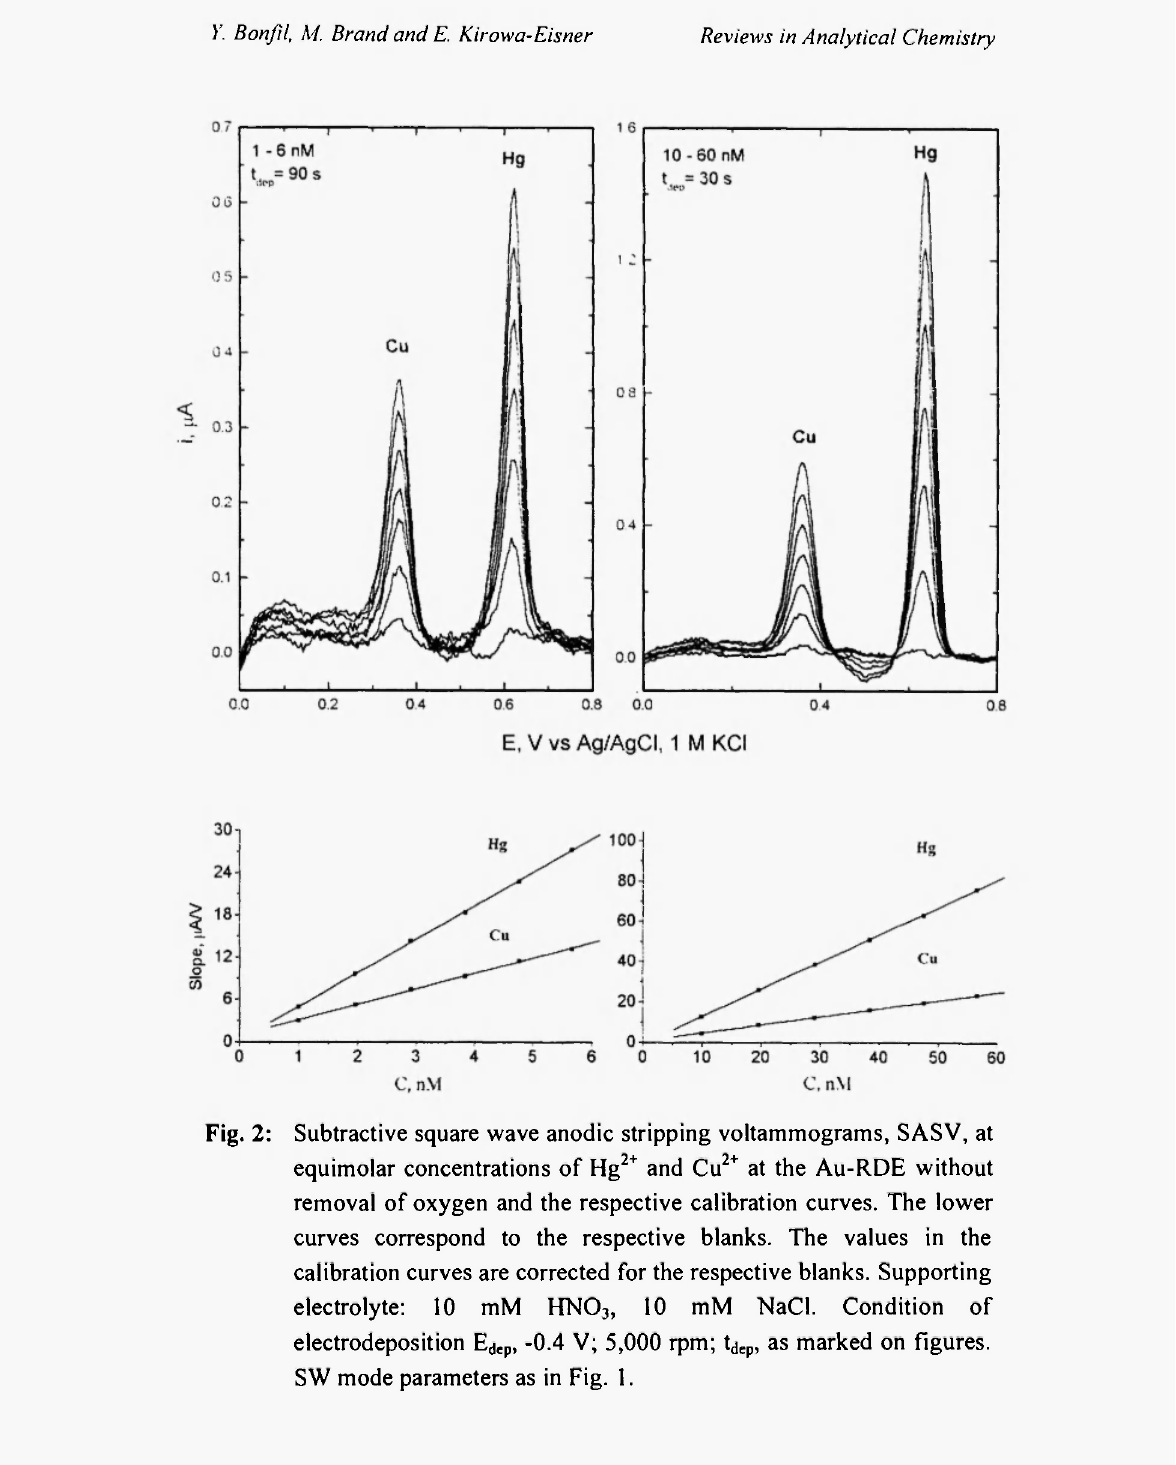
Fig. 2: Subtractive square wave anodic stripping voltammograms, SASV, at equimolar concentrations of Hg 2+ and Cu 2+ at the Au-RDE without removal of oxygen and the respective calibration curves. The lower curves correspond to the respective blanks. The values in the calibration curves are corrected for the respective blanks. Supporting electrolyte: 10 mM HN0 3 , 10 mM NaCl. Condition of electrodeposition E dep , -0.4 V; 5,000 rpm; t dep , as marked on figures. SW mode parameters as in Fig. 1.